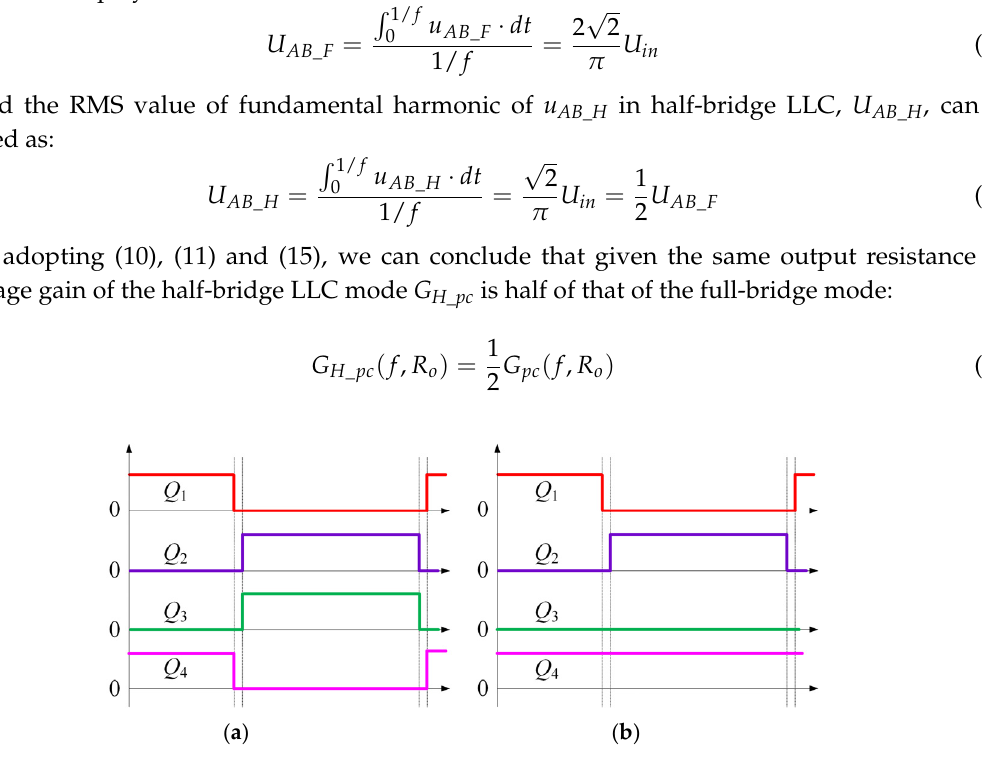
Figure 5. Drive signals of the proposed changing topological LLC: ( a ) Full-bridge LLC; and ( b ) Half-bridge LLC.